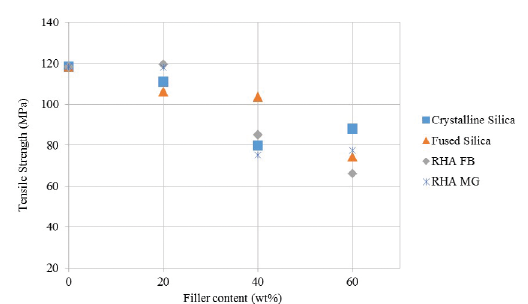
Figure 14. Tensile strength of composites (MPa). Notice the increased load level at breaking point